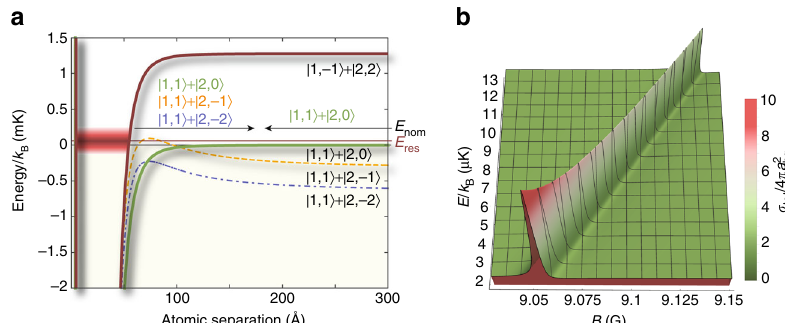
Fig. 1 Interaction potentials and scattering cross section. a Relevant long range s -wave and d -wave potential curves 52 involved in the Feshbach resonance between incident atoms in the | 1, 1 〉 + | 2, 0 〉 hyper fi ne states, labeled according to the free atom states to which they connect. The | 1, − 1 〉 + | 2, 2 〉 potential curve corresponds to a s -wave closed channel supporting a quasi-bound state to which the interacting atoms can couple during the collision, provided that the difference in the collision energy of the atoms E nom and the energy of the bound state is small. From the bound state the atoms can elastically scatter back into the s -wave entrance channel or decay into either of the two dominant d -wave open channels, | 1, 1 〉 + | 2, − 1 〉 and | 1, 1 〉 + | 2, − 2 〉 (inelastic scattering). b The total scattering cross section of the 9.040 G resonance as a function of applied bias fi eld and collision energy of the